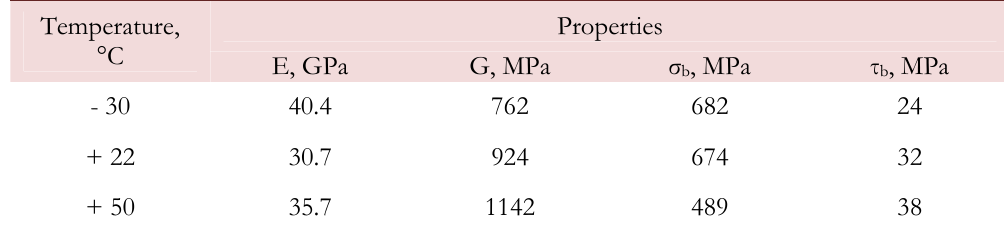
Table 2: Unidirectional fiberglass (Direct "E" roving 0.7 - orthophthalic polyester resin 0.3) properties at bending tests